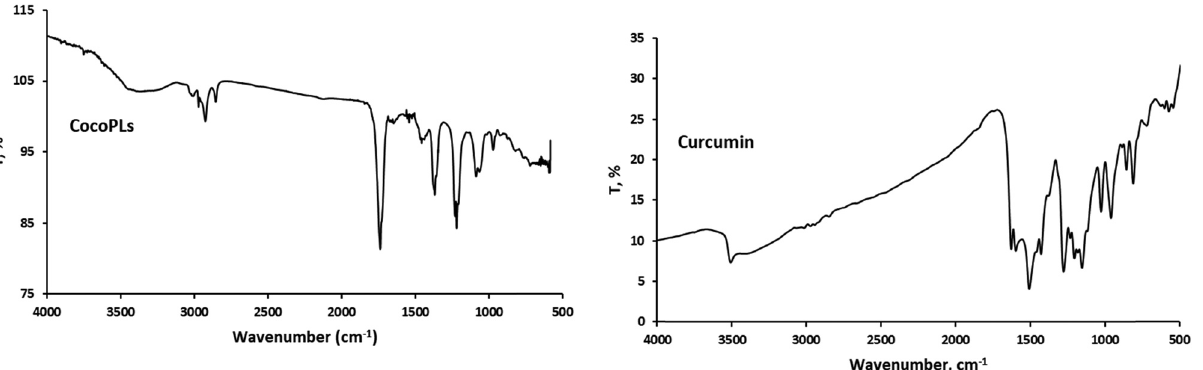
Figure 1: Fourier transform infrared spectra of coconut phospho - lipids ( CocoPLs ) .